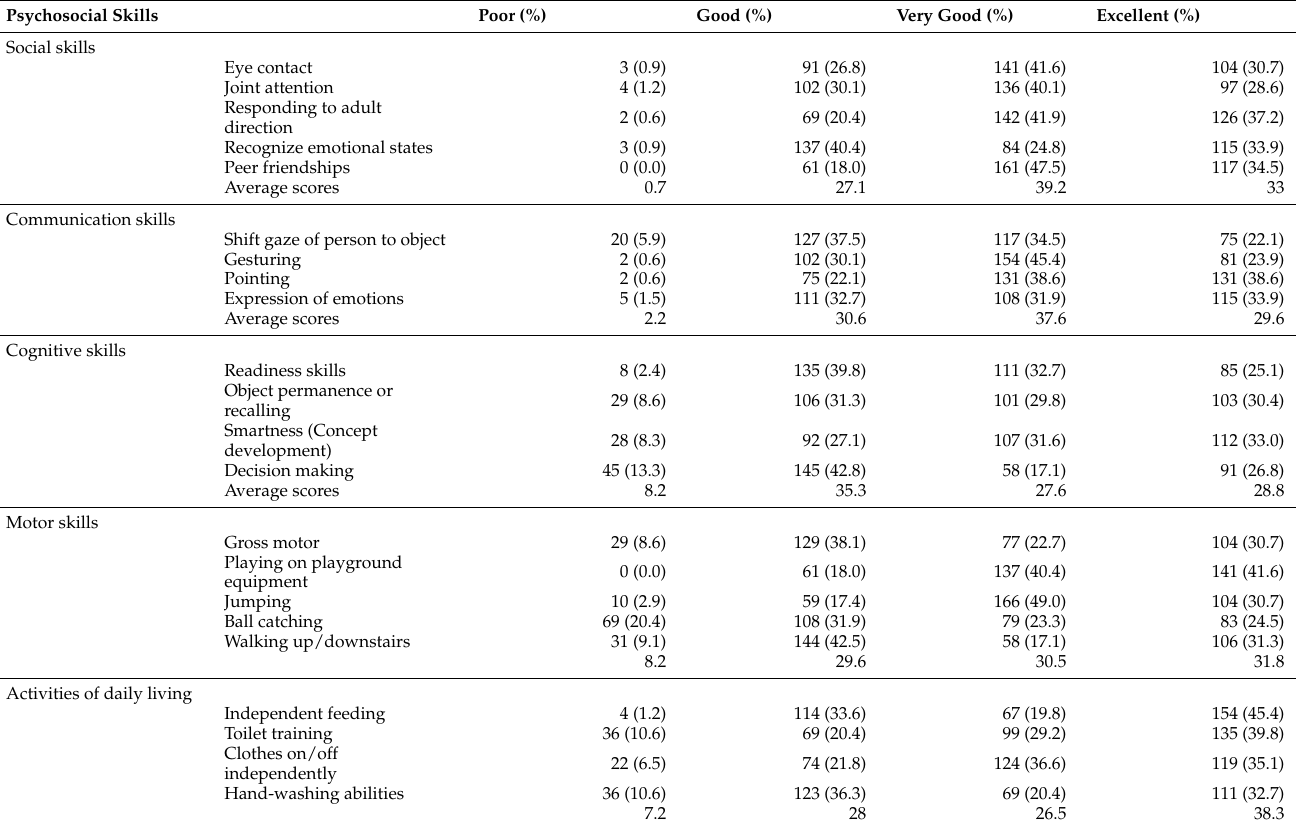
Table 1. Psychosocial skills of offspring between 3 to 5 years (n =